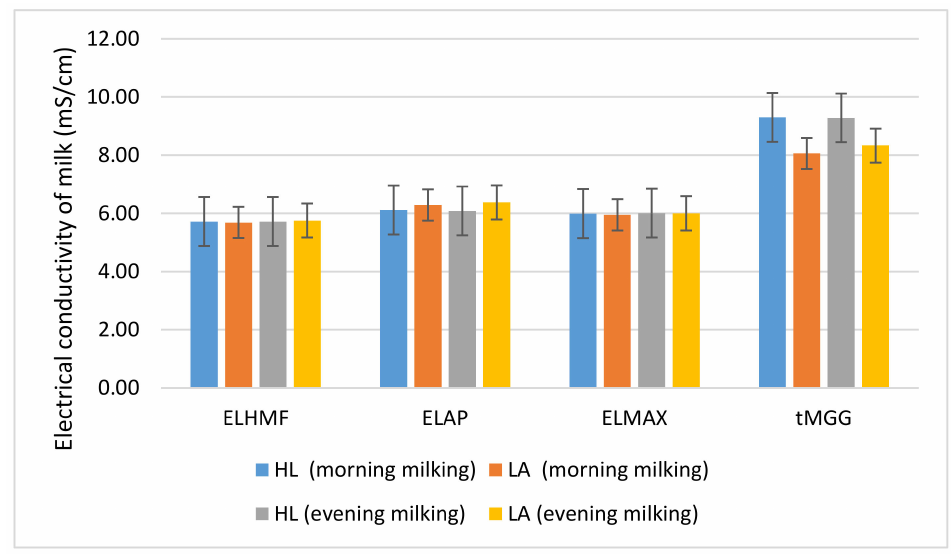
Figure 2. Electrical conductivity traits (mS/cm) in milk of cows by milking.